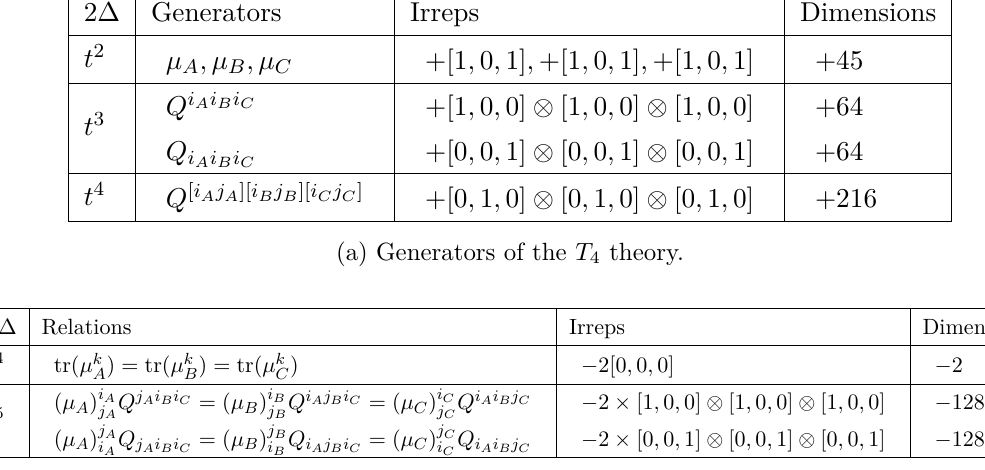
Table 26. The generators and some relations of the T 4 theory, ordered by their conformal dimension ∆ along with the irreps they transform under and their dimensions, are summarised in a and b, respectively. [ n 1 , n 2 , n 3 ] is the Dynkin label for su (4)